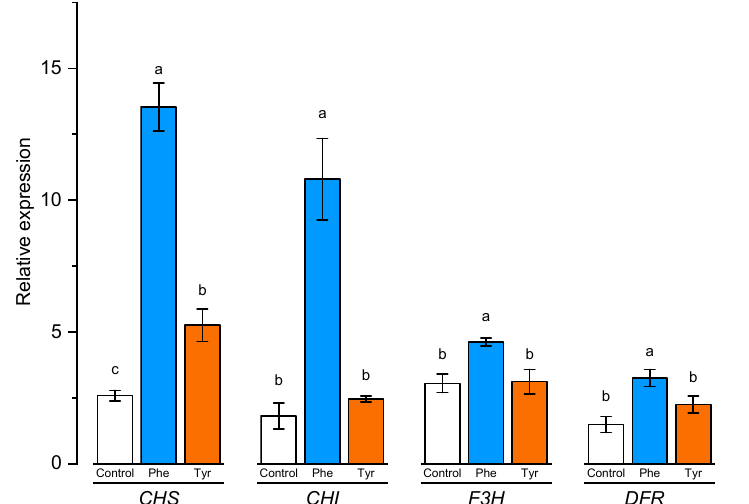
Figure 7. Relative quantification values of CHS, CHI, F3H, and DFR in wheat leaves in the presence of phenylalanine and tyrosine. Bars marked with different letters show significant differences at ( p ≤ 0.05) according to Tukey’s test. A total of three biological and three technical replicates were conducted.